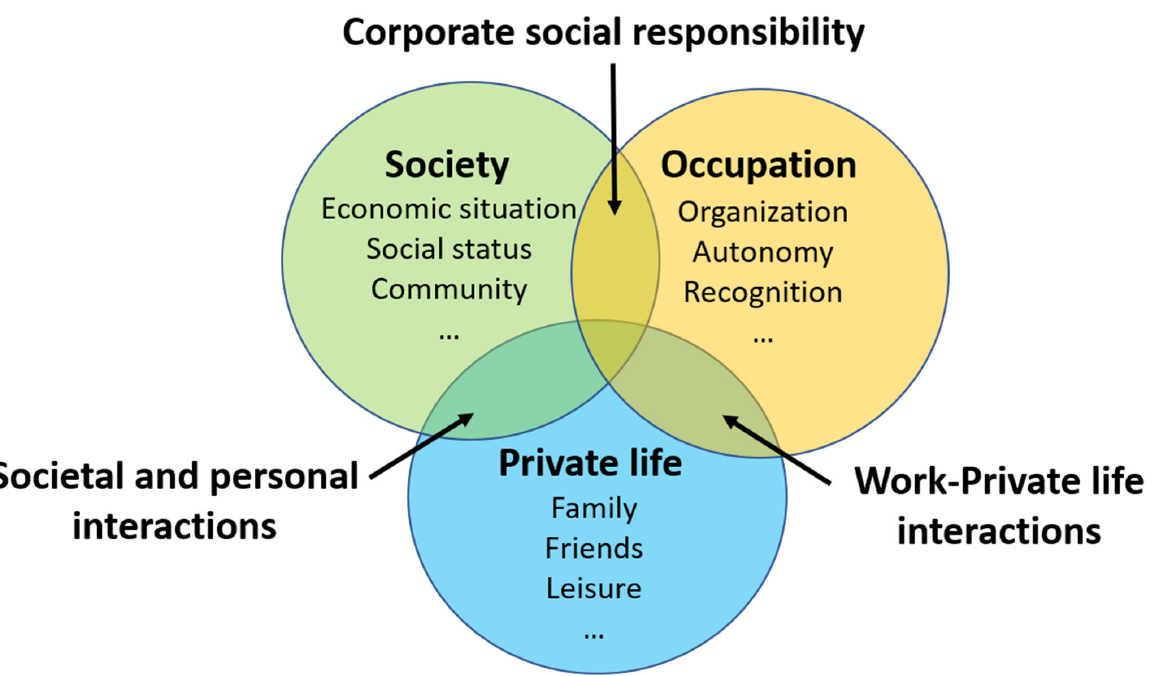
Figure 5. Examples of supports to core values in each sector of daily life. Each sector intersects and supports the others.